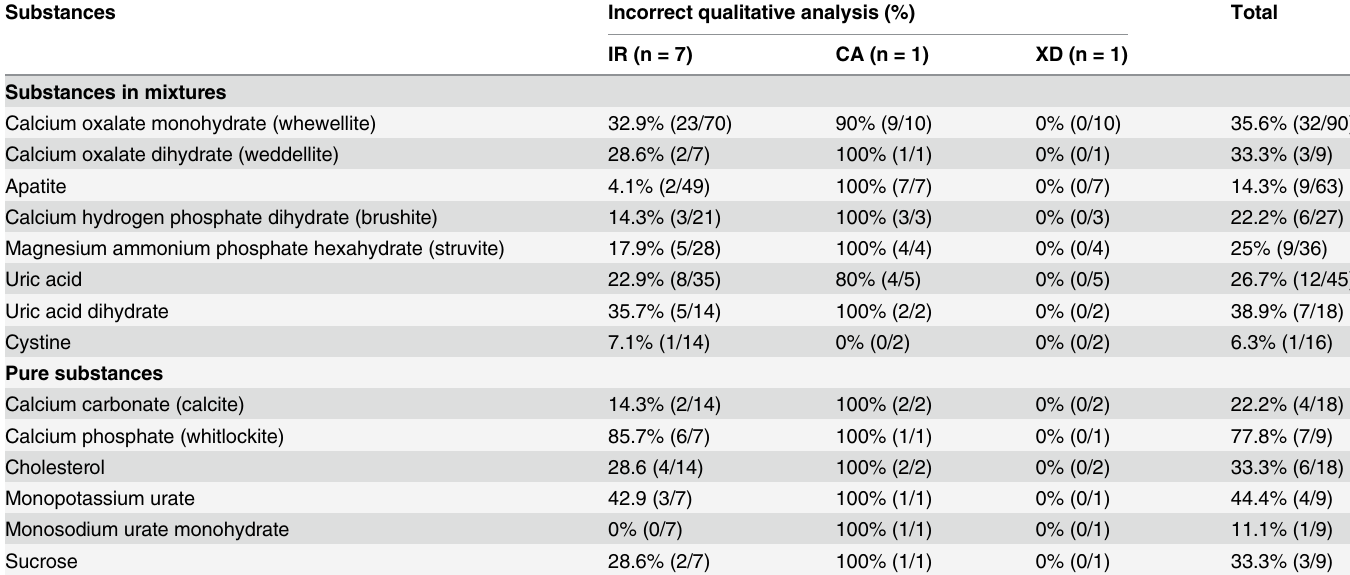
Table 3. Error rates of qualitative analysis for test substances.